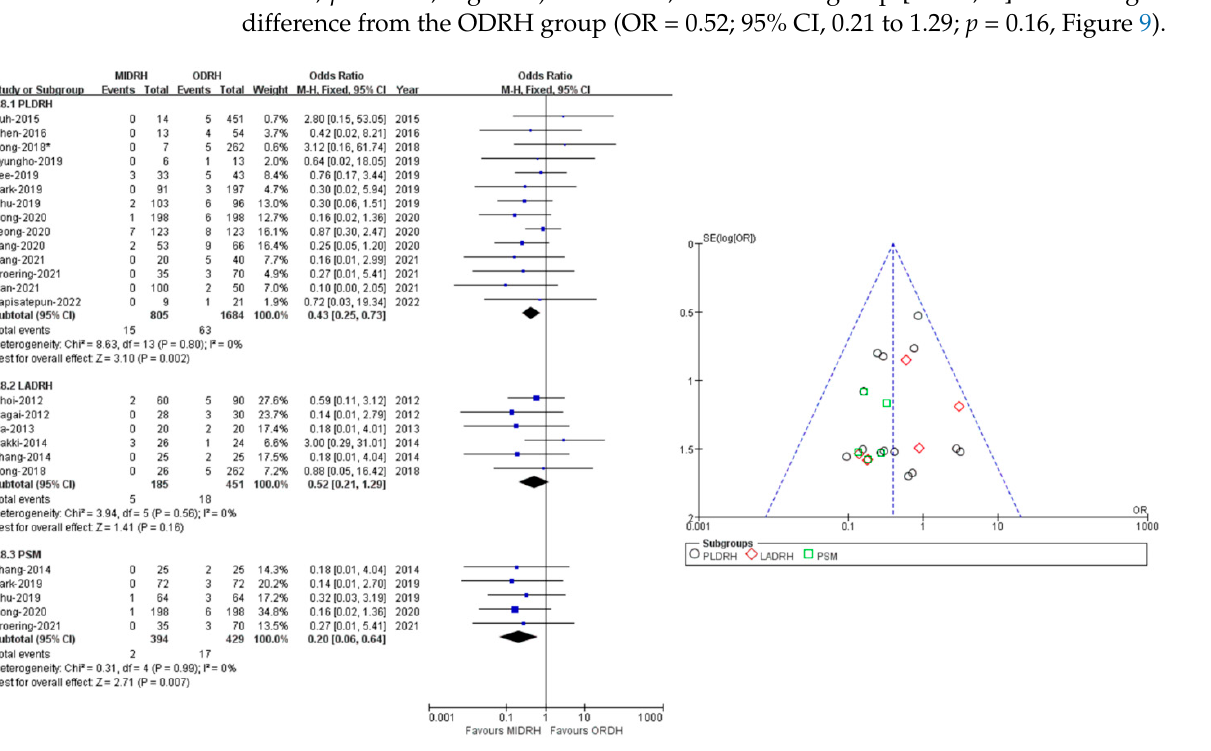
Figure 9. Forest plot and funnel plot comparison of MIDRH versus ODRH for wound